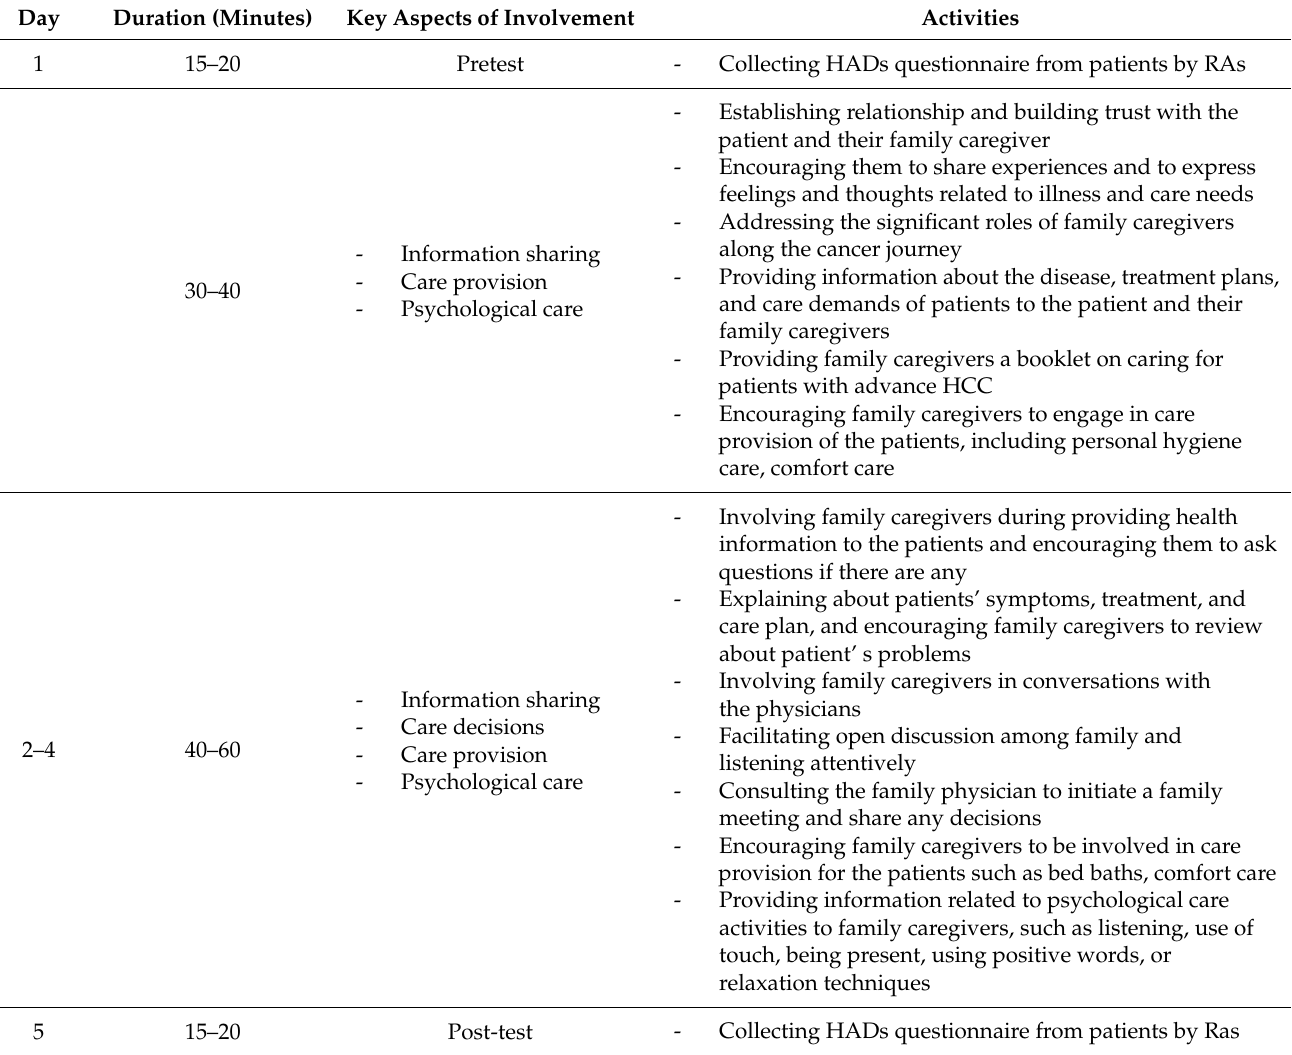
Table 1. Schedule and contents for the 4-day nurse-led family involvement